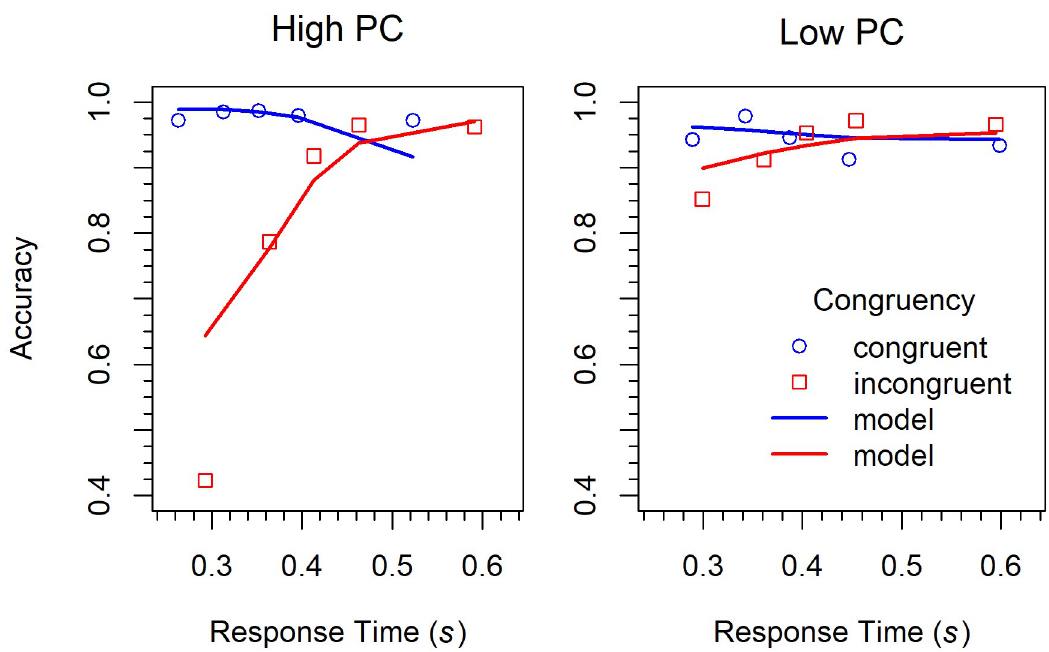
Fig 12. Conditional accuracy functions for the different conditions in Experiment 3 (Simon task). The lines represent the fit of the DMC model.